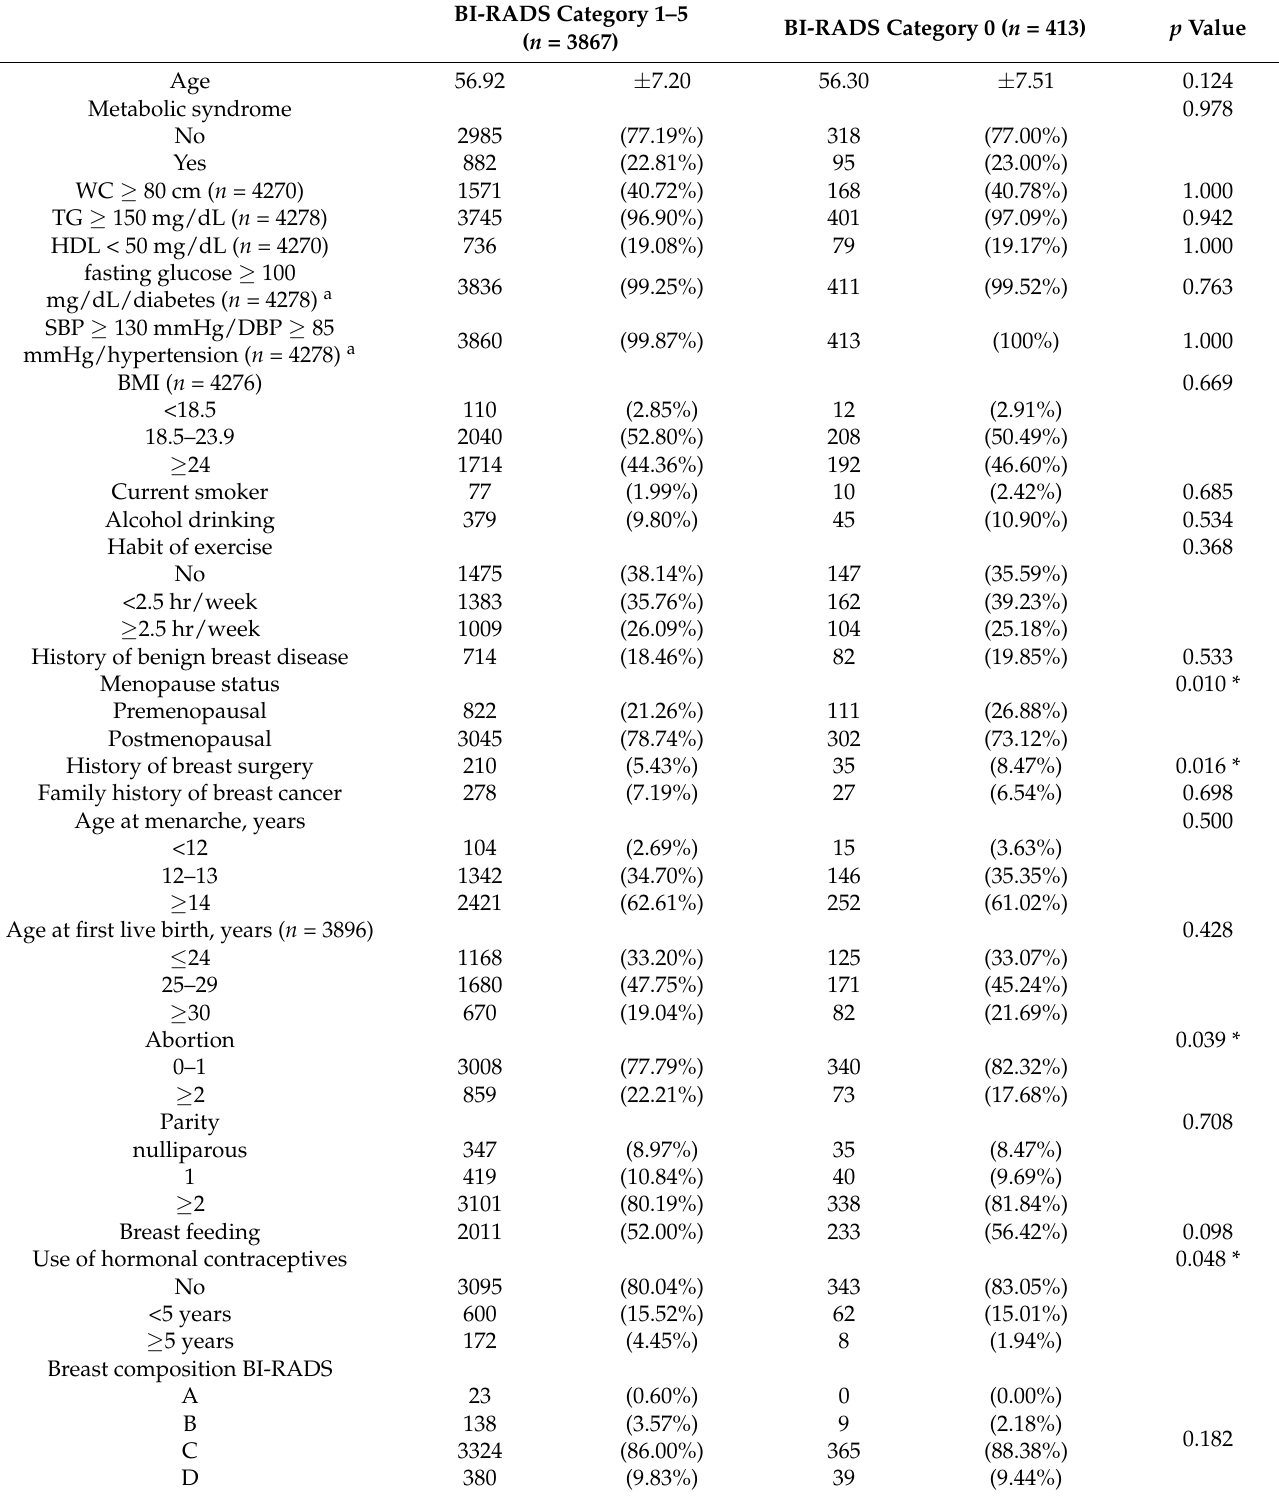
Table 1. Clinical characteristics and component of metabolic syndrome of participants by BI-RADS